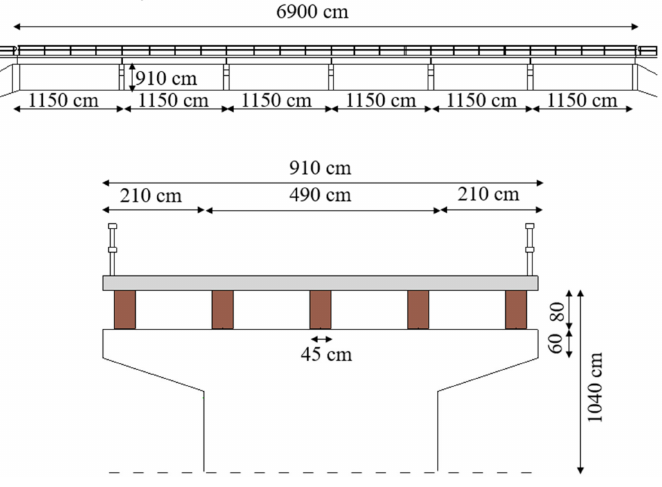
Figure 13. Front elevation and section of Ghalilah bridge.